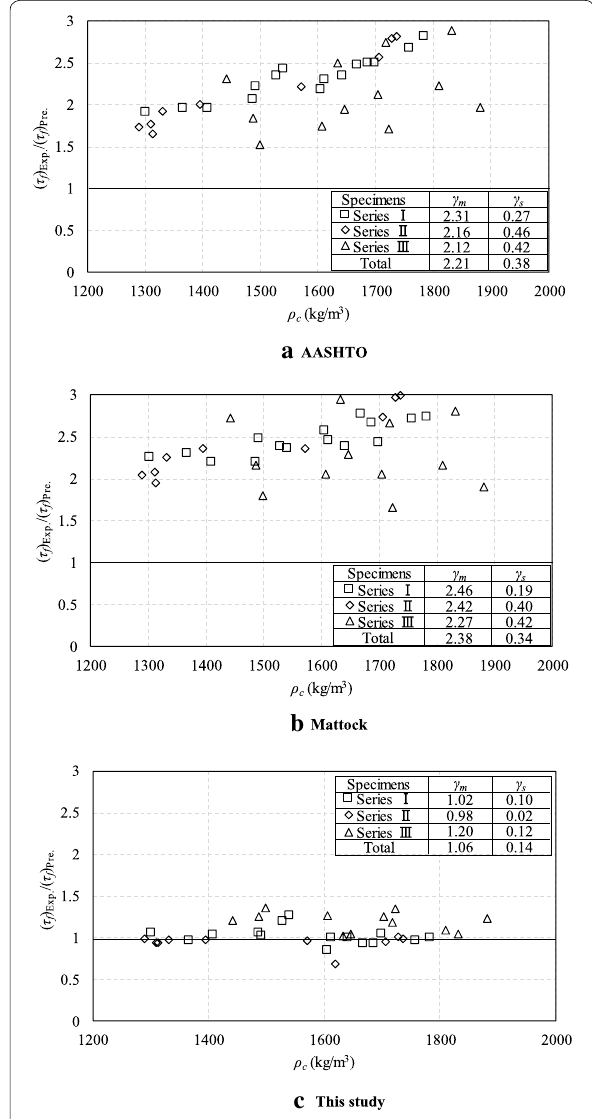
Fig. 9 Comparisons of measured and predicted shear friction capacities for LWAC‑BS; a AASHTO; b Mattock; c this